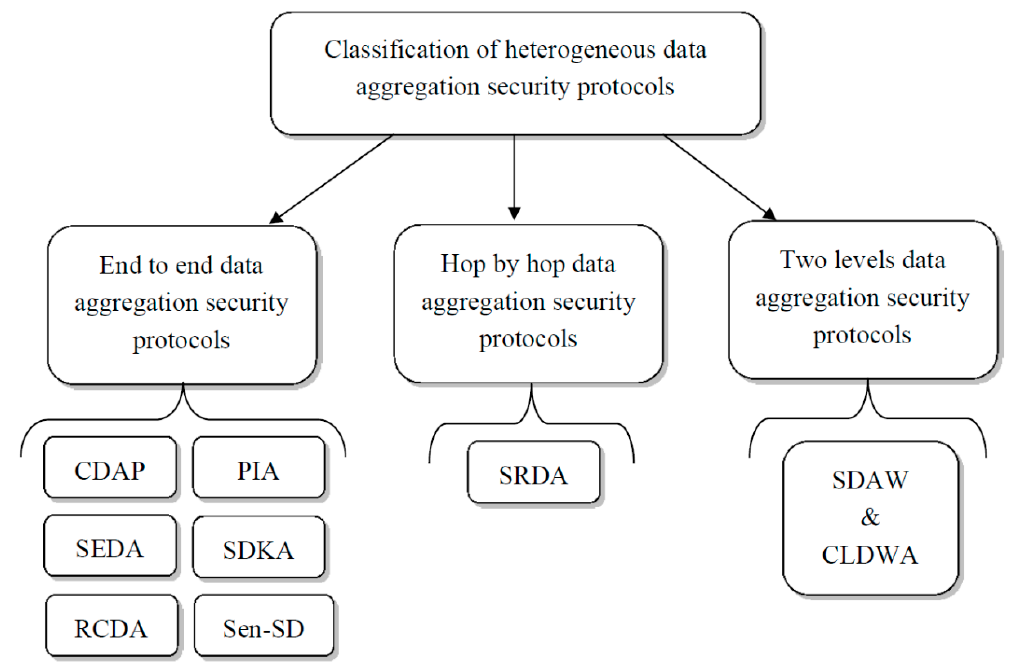
Figure 2. Heterogeneous data aggregation security protocol classification.